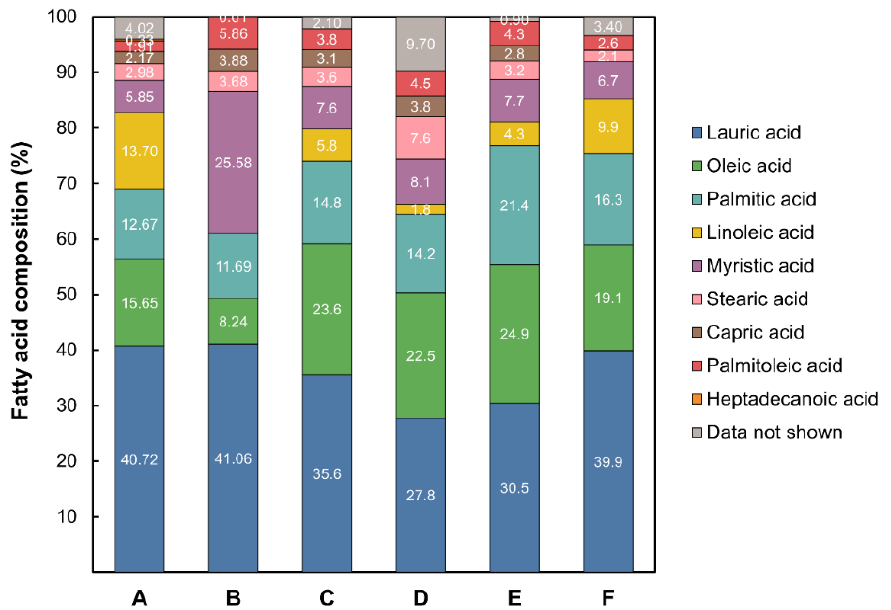
Figure 4. Comparison of composition of fatty acids extracted from BSFL in previous studies con- ducted in Asian countries. A: Analyzed in current study. Fatty acids were extracted from BSFL fed A: Analyzed in current study. Fatty acids were extracted from BSFL fed with processed food waste for 7 days; B: Data with processed food waste for 7 days; B: Data from [47]; C: Data from [57]; D: Data from [42]; E: from [47]; C: Data from [57]; D: Data from [42]; E: Data from [63]; F: Data from Data from [63]; F: Data from [74].